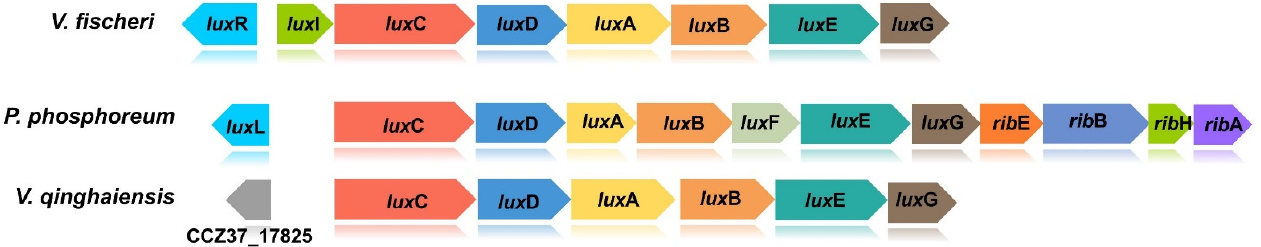
Figure 1. The arrangement of bacterial luminescence ( lux ) genes in three bacteria. Comparison of the size and order of lux genes in three bacteria using diverse colour arrangements to highlight commonalities and differences.